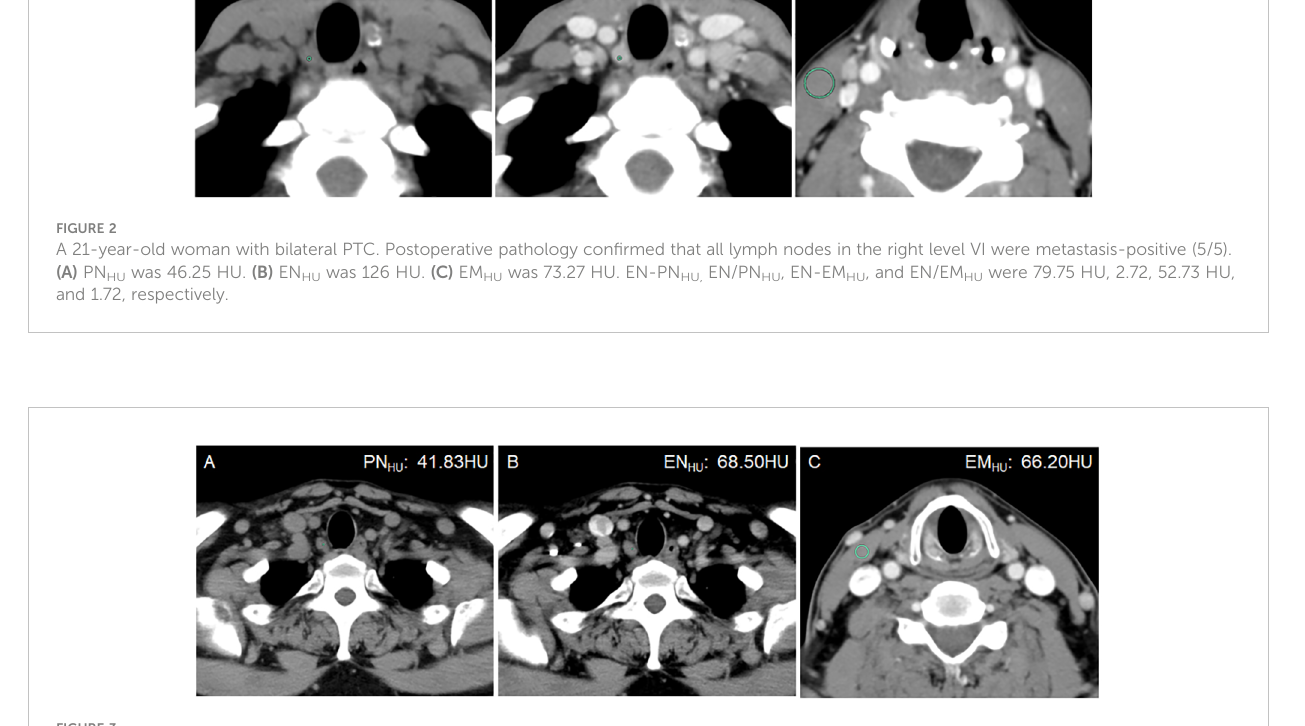
FIGURE 3 A 50-year-old man with bilateral PTC. Postoperative pathology con fi rmed that all lymph nodes in the right level VI were metastasis-negative (0/5). (A) PN HU was 41.83 HU. (B) EN HU was 68.50 HU. (C) EM HU was 66.20 HU. EN-PN HU , EN/PN HU , EN-EM HU , and EN/EM HU were 26.67 HU, 1.64, 2.3 HU, and 1.02,